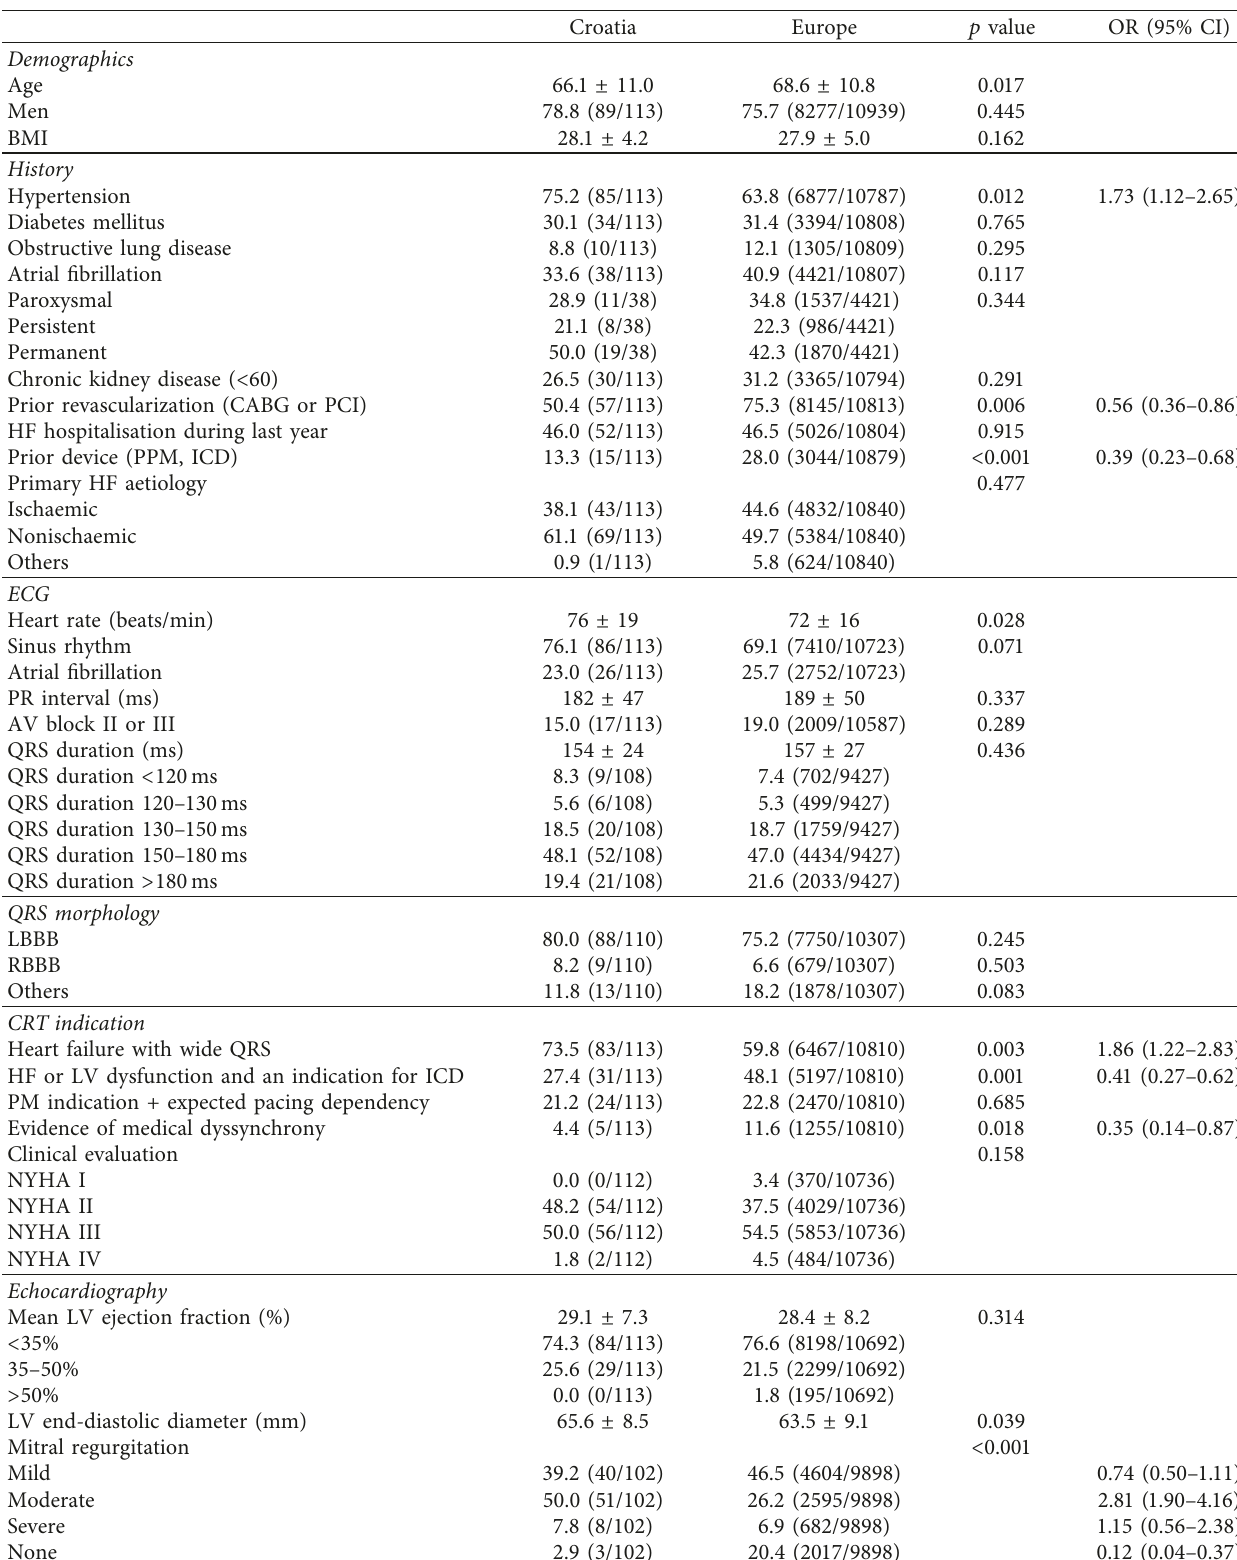
Table 1: Baseline characteristics and preprocedural data of Croatian CRT population and comparison with the European